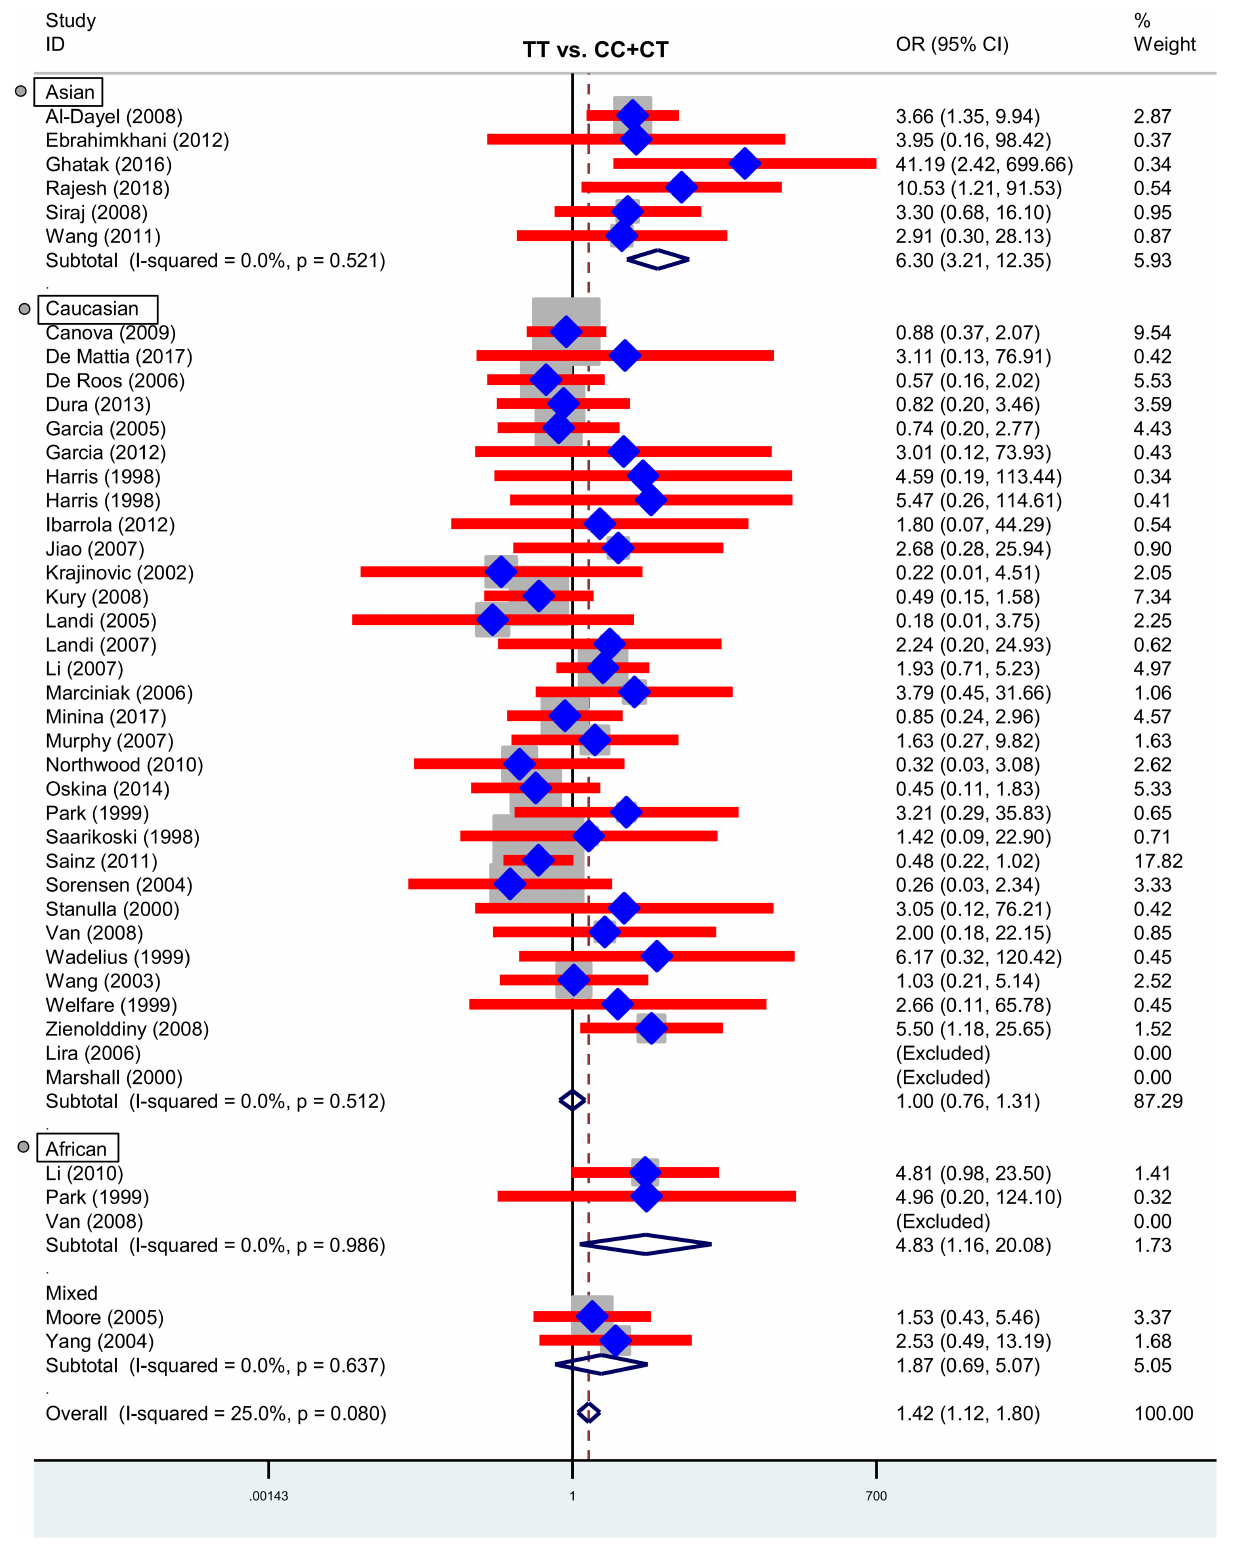
Frontiers in Physiology |